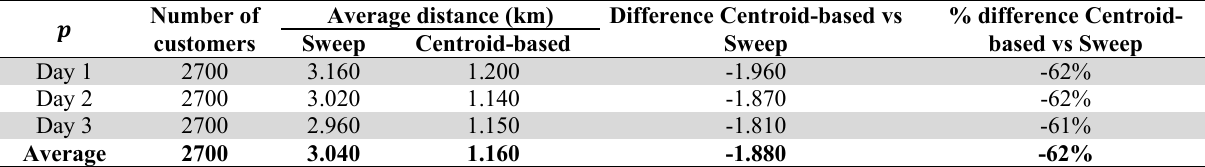
Results of clustering phase for three days in the case study